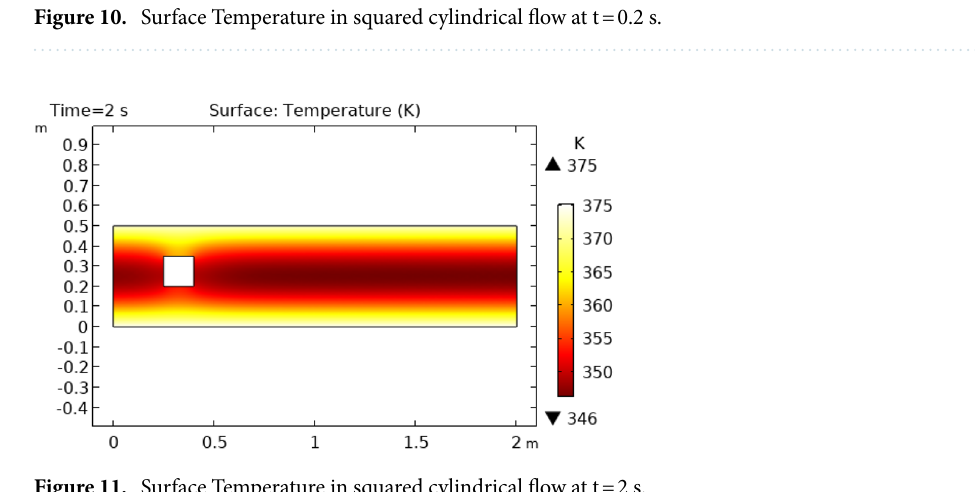
Figure 11. Surface Temperature in squared cylindrical flow at t = 2